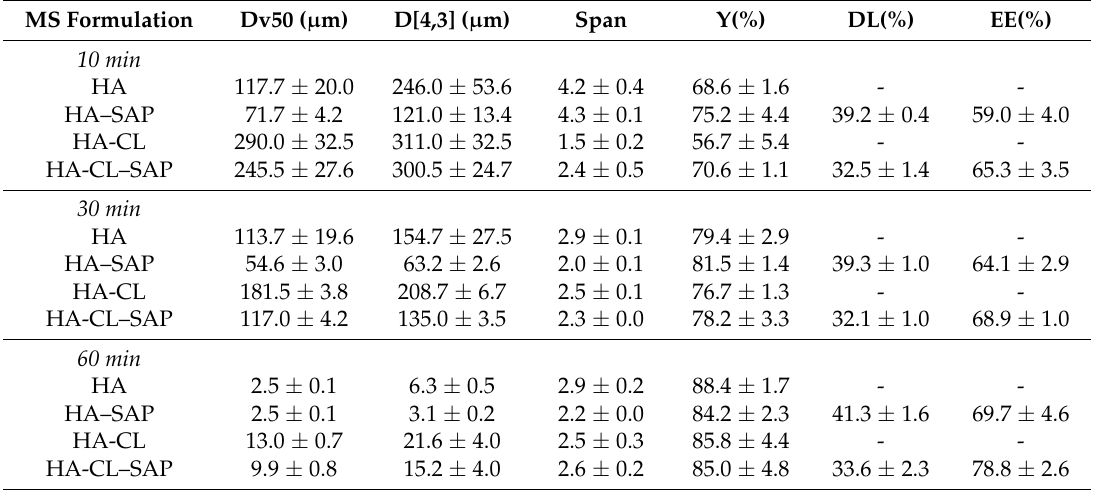
Table 2. Effect of emulsification time, polymer type, and SAP presence on MS properties ( n = 3, ± SD). MS